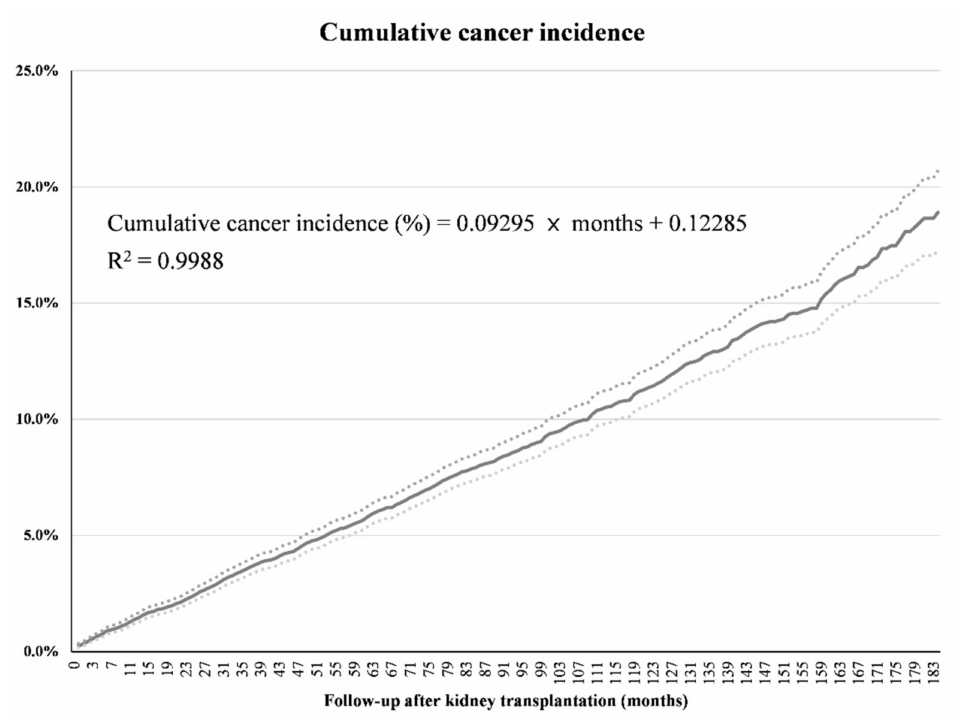
Figure 1. Cumulative cancer incidence rate using Kaplan–Meier analysis during the follow-up period after kidney transplantation. The dashed lines indicate the 95% confidence interval (CI) of the cumulative cancer incidence according to the length of the follow-up (in months). The equation was derived using data from up to 157 months of follow-up; the 95% CI of the slope and y-intercept are 0.09245 to 0.09345 and 0.07737 to 0.16834,